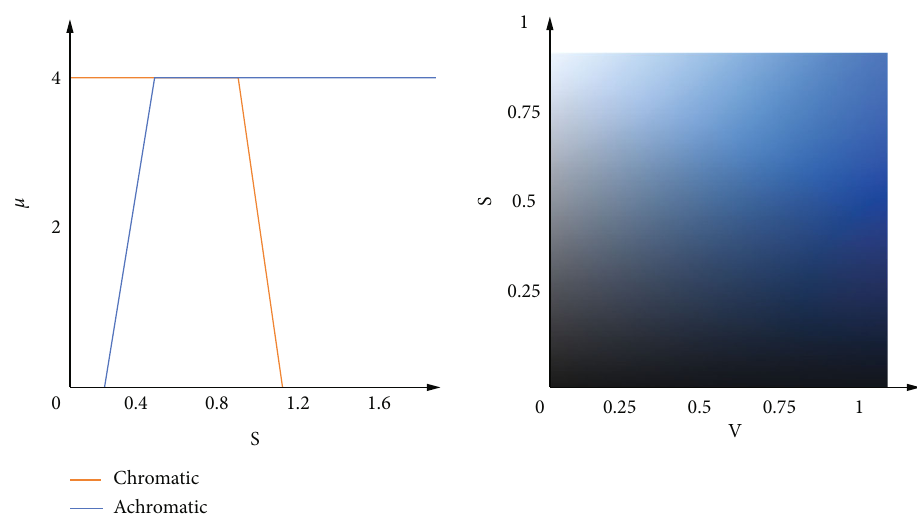
Figure 5: Variation of color with S and V at H = 0 (left) and S -component fuzzy set partition (right).